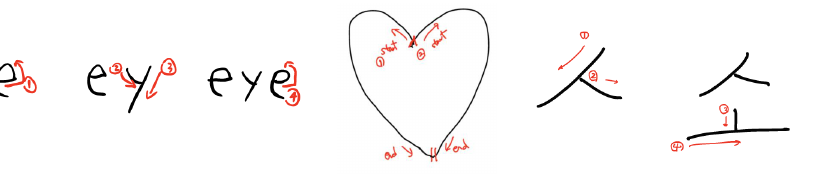
Figure 2. Details of English, Freestyle, and Korean